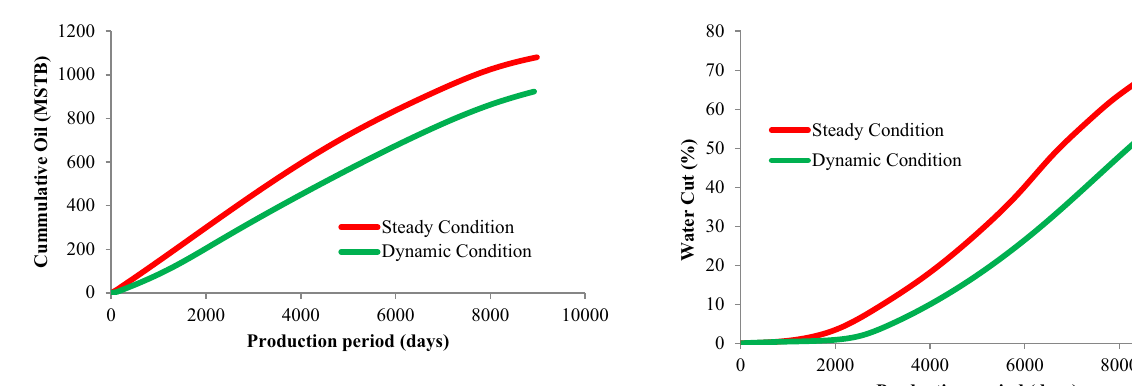
Fig. 9 Cumulative oil with production period